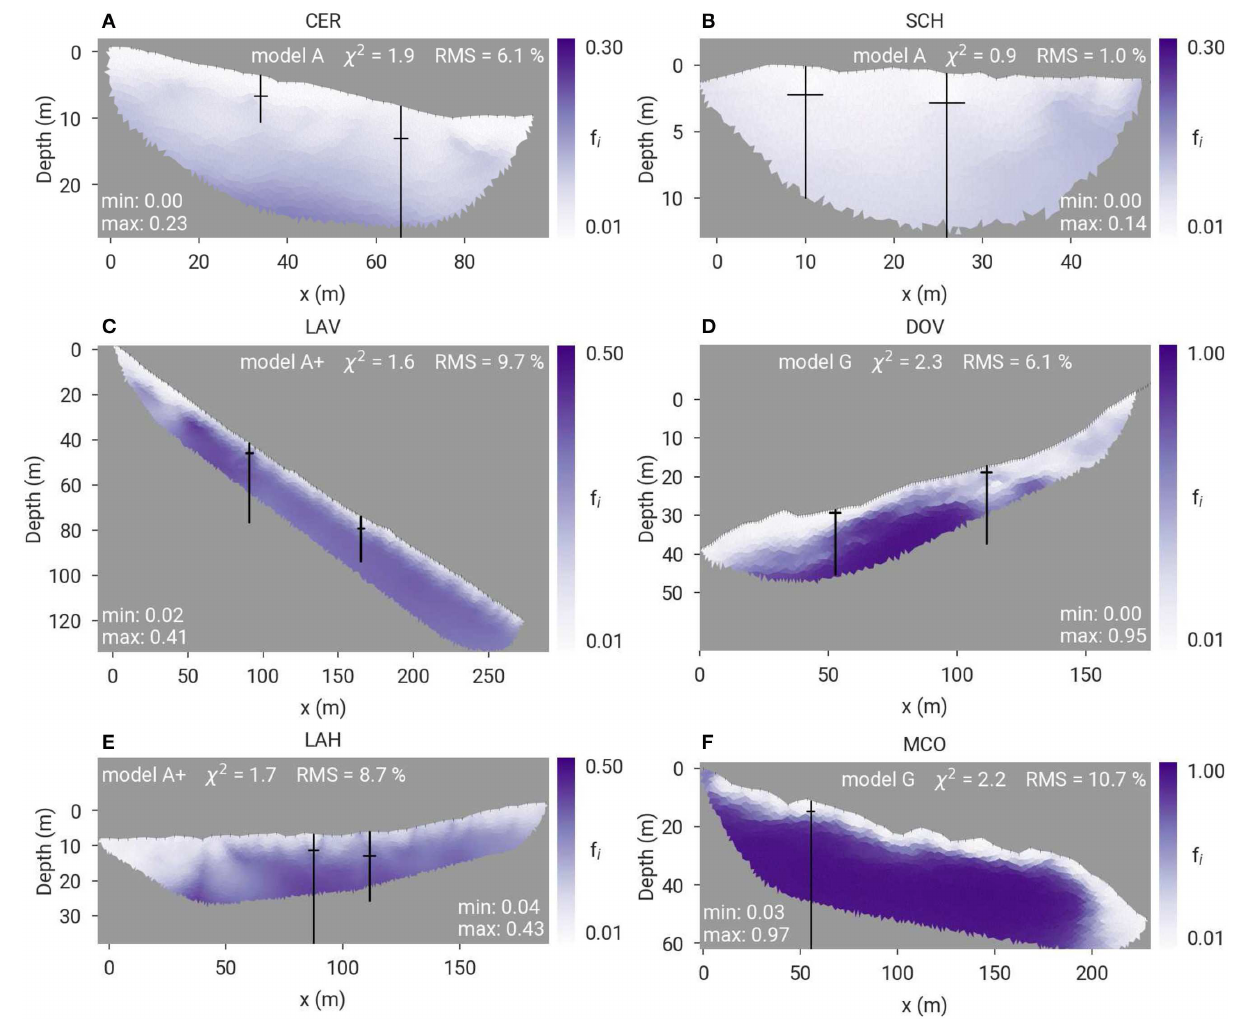
FIGURE 12 | Summary of best-guess ice content distribution for all study sites: (A) CER, (B) SCH (after Wagner et al., 2019), (C) LAV, (D) DOV, (E) LAH, and (F) MCO according to the resistivity model with the highest confidence, respectively (indicated in each panel). Note the different color scales. Minimum and maximum estimated ice content as well as the RMS are also indicated in each panel. Boreholes and associated thaw depths are marked by black